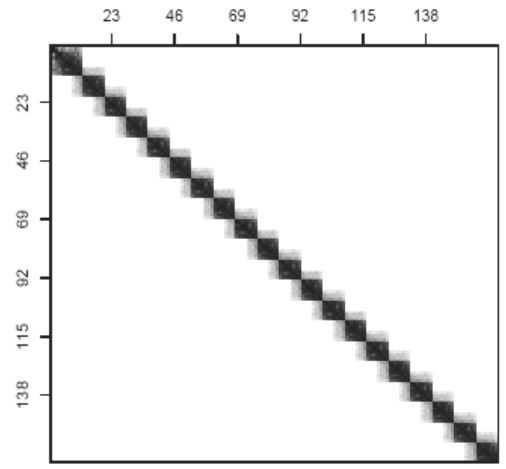
Figure 1 – Image of a partial correlation matrix for 164 variables. Every entry of the matrix is repre- sented as a gray-scaled point between zero (white points) and ±1 (black